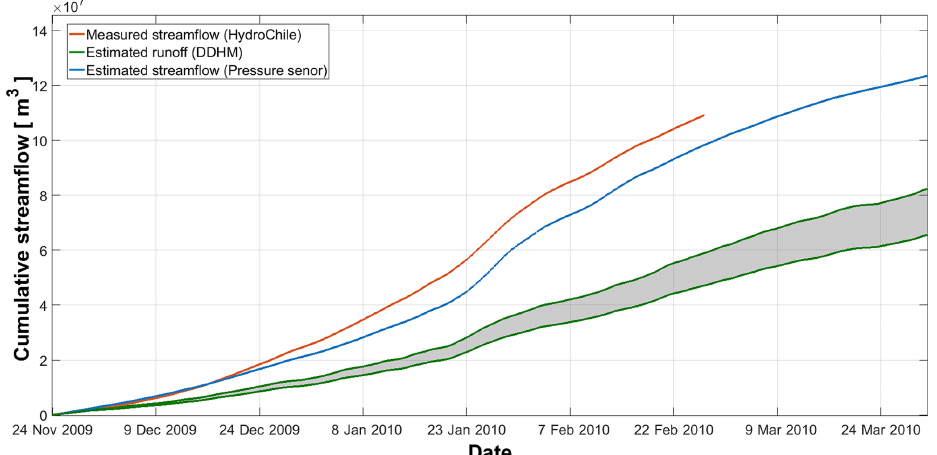
Figure 11. Comparison of cumulative melt calculated with the distributed degree-hour model (grey area) and streamflow measurements from the water level sensor data and the HydroChile station.